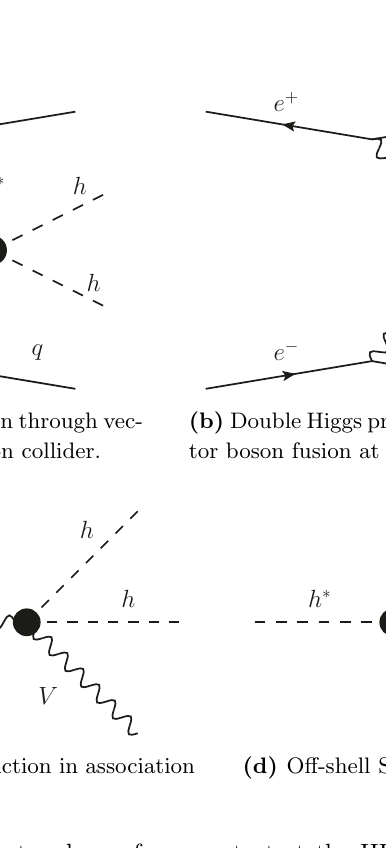
Figure 7. Production and decay topology of venues to test the HHVV couplings. A black dot represents contributions from various Feynman diagrams. To measure the HVVV coupling, replace one of the external Higgs particle by an electroweak gauge